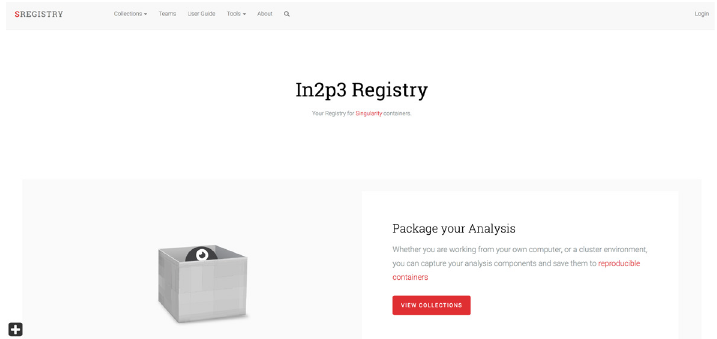
Figure 2. A Singularity private Hub for